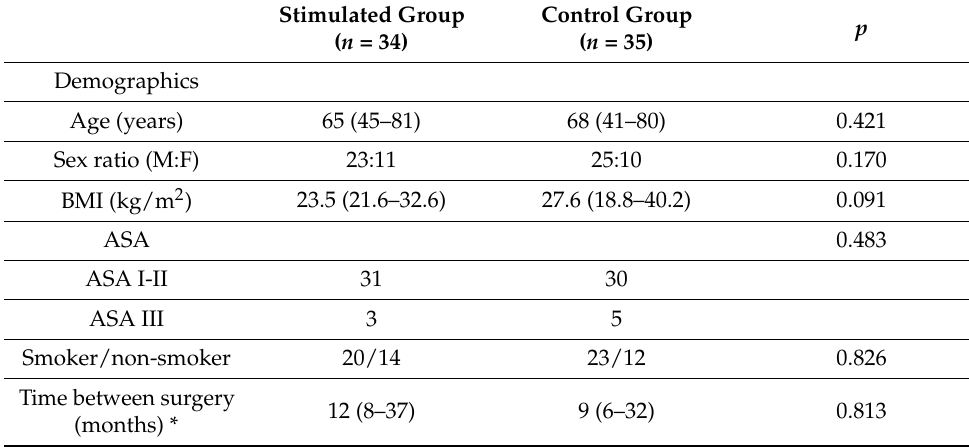
Table 1. Sociodemographic and clinical variables and endoscopic and histological severity index of diversion colitis between the stimulated group (SG) and the control group